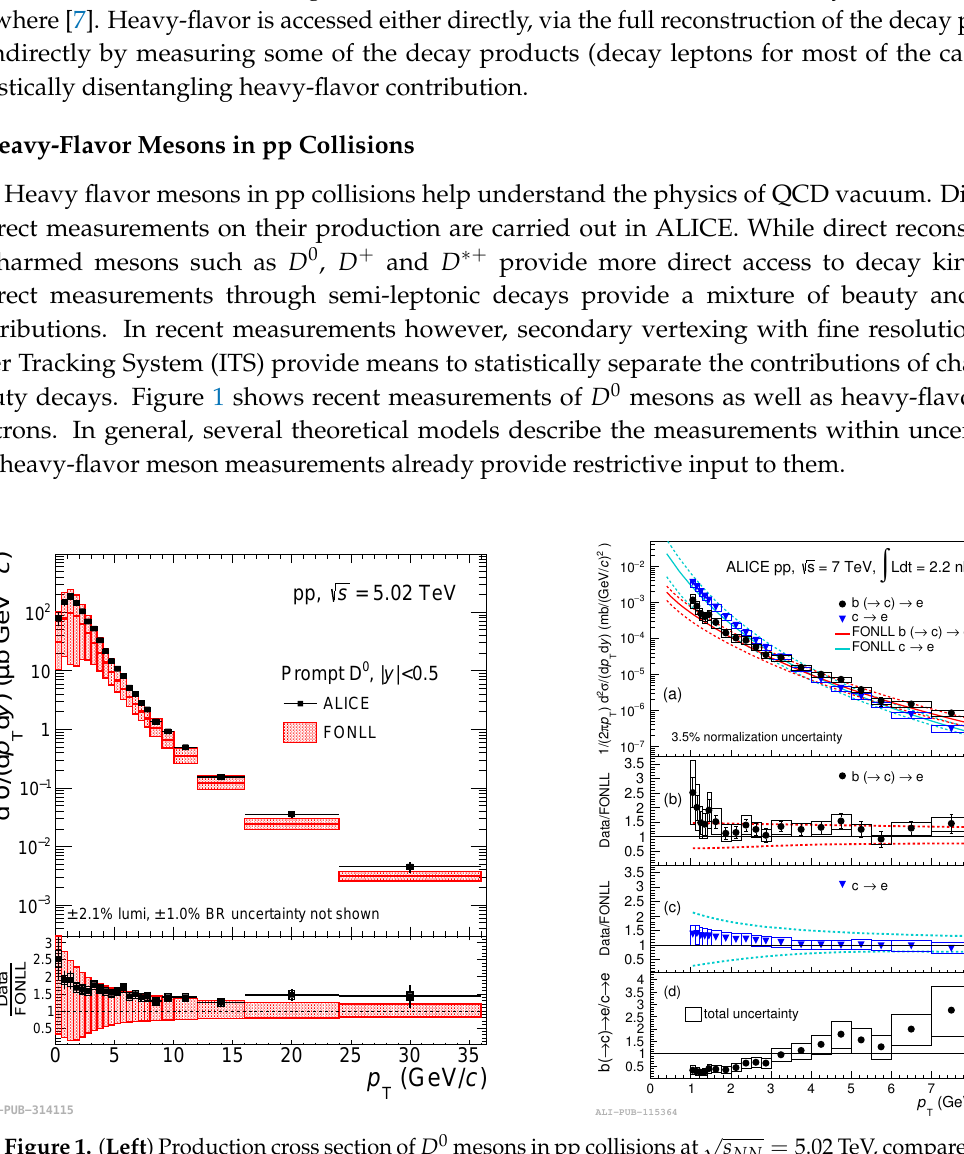
Figure 1. ( Left ) Production cross section of D 0 mesons in pp collisions at a theoretical calculation [8]. ( Right ) Production cross section and beauty faction of heavy-flavor √ s NN = 7 TeV, compared to a theoretical calculation electrons in pp collisions at